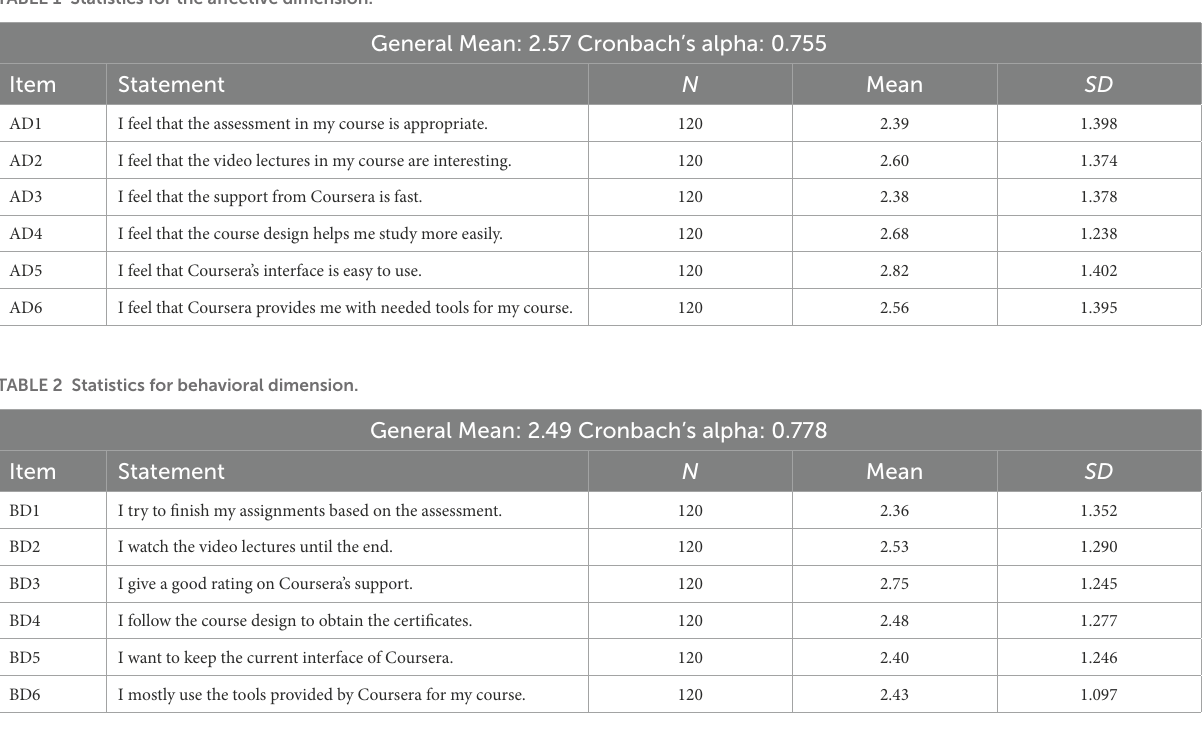
TABLE 1 Statistics for the affective dimension.